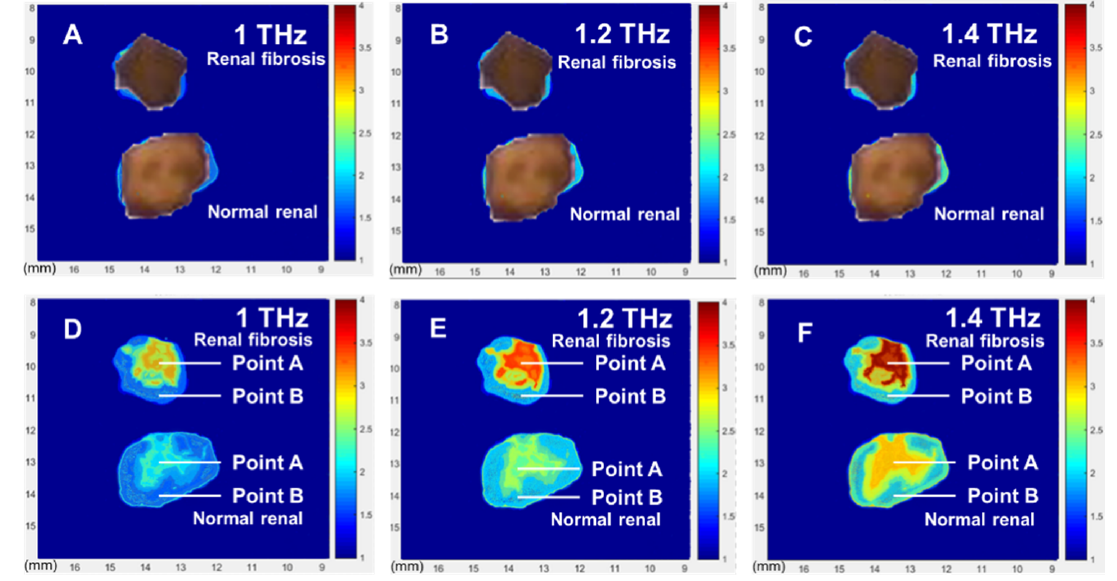
Figure 4. Spatial distribution of HYP in terahertz absorption images. ( A – C ) are the optical images from the THz imaging of the renal fibrosis tissues from UUO mice and normal tissues from the sham group, corresponding to pictures ( D – F ). ( D – F ) are the THz images of these tissues at the frequencies of 1.0, 1.2, 1.4 THz, respectively. The pictures above are of the renal fibrosis tissues, and the pictures below are of the normal renal tissues.